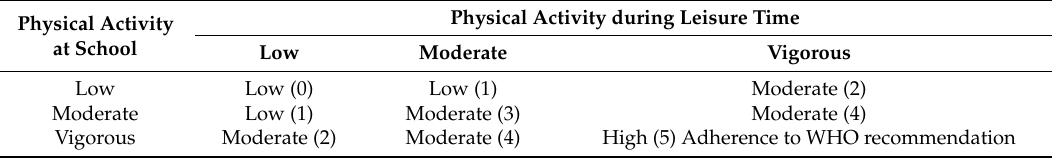
Table 2. Categorising and scoring (points) of physical activity based on physical activity at school and during leisure time.